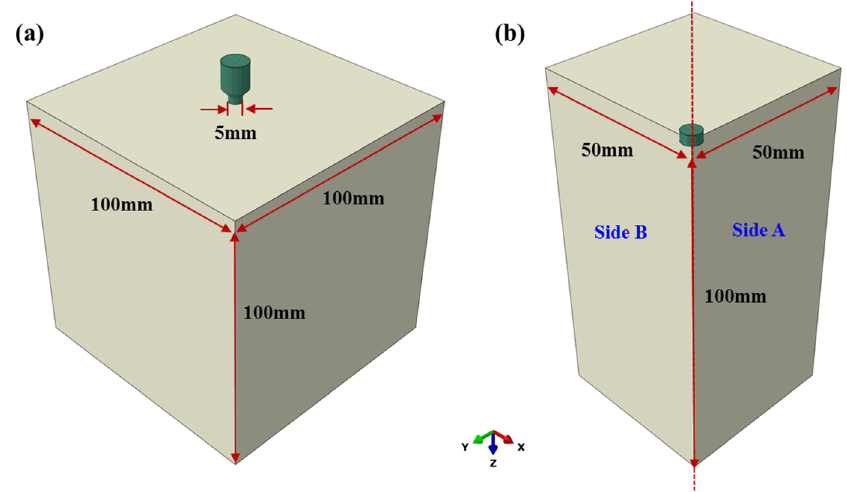
Figure 3. The 3D finite element model: ( a ) The whole model. ( b ) A quarter of the model.